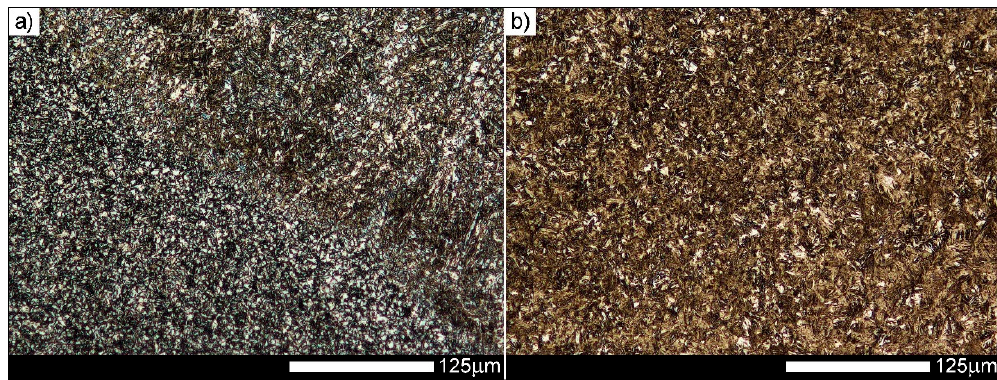
Figure 13. Microstructures of the Hardox 600 joint within the fusion zone—FZ2 in Figure 3: ( a ) after welding; and ( b ) after welding and heat treatment. Light microscopy, etched with 2% HNO 3 .